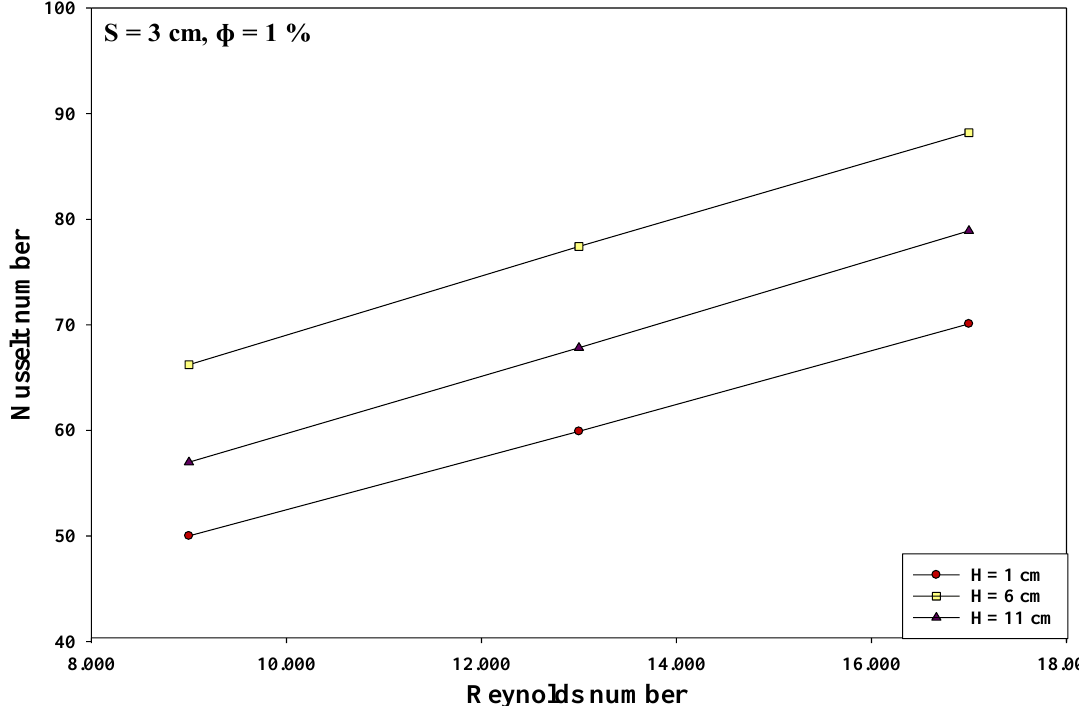
Figure 9. Effect of the Reynolds number and nozzle – plate distance when the nozzle – nozzle distance was 3 cm and other factors were maintained at their optimal levels.